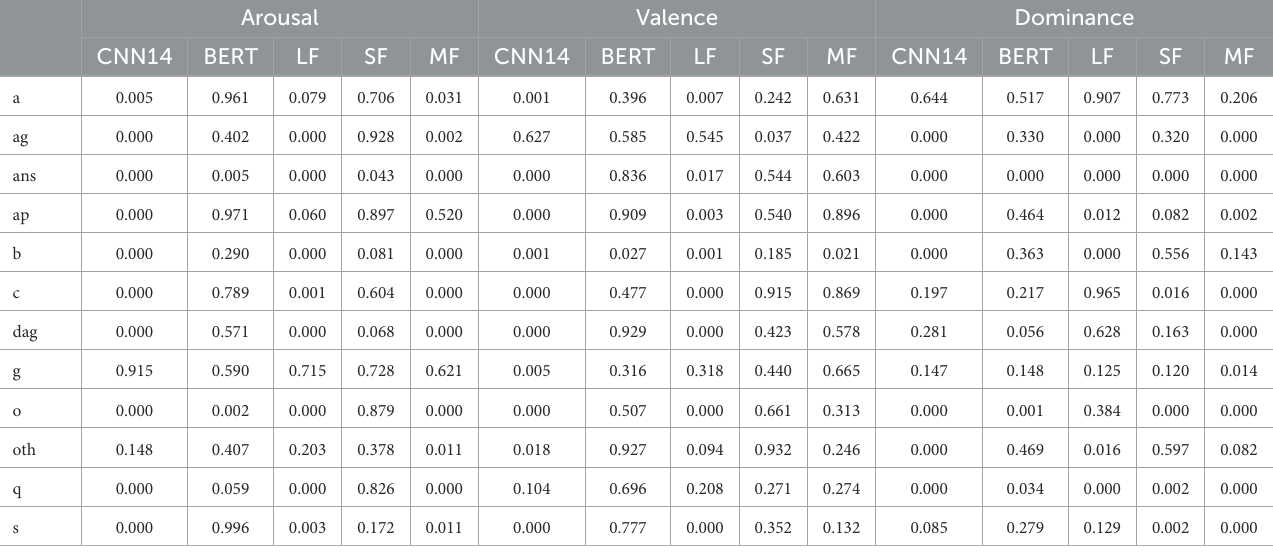
TABLE 4 P -values from a two-sided t -test for 0-mean error residuals for emotional dimension prediction on IEMOCAP stratified for the different dialogue acts. Arousal Valence Dominance